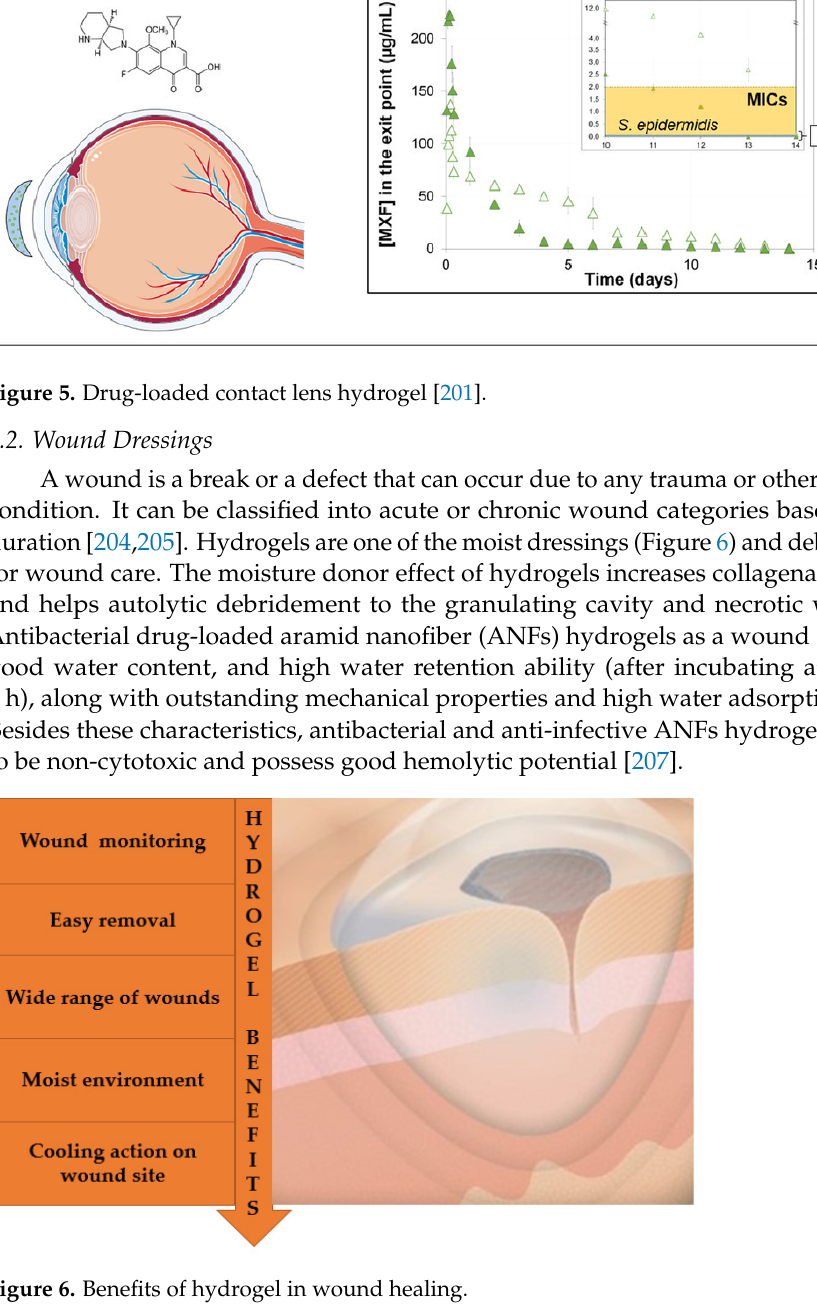
Figure 6 . Benefits of hydrogel in wound healing. Figure 6. Benefits of hydrogel in wound